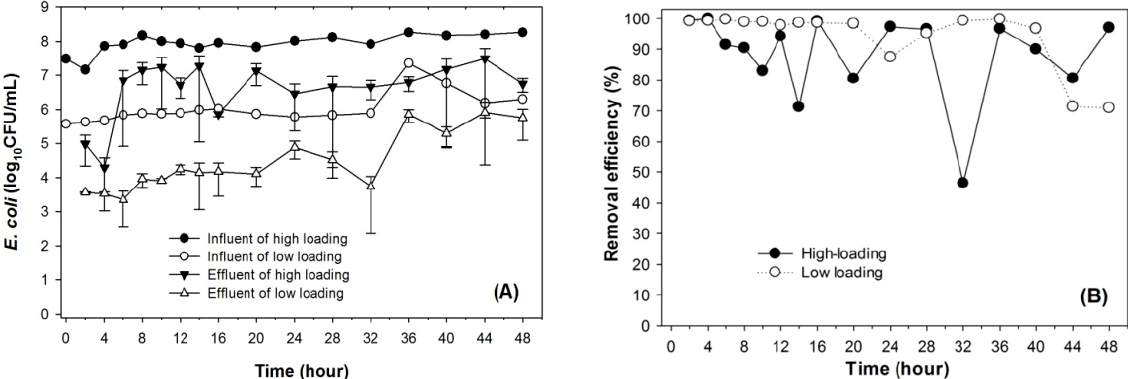
Figure 2. Adsorption of E. coli to the soil columns at two different bacterial loadings. ( A ) Influent and effluent concentrations, ( B ) Removal efficiencies.